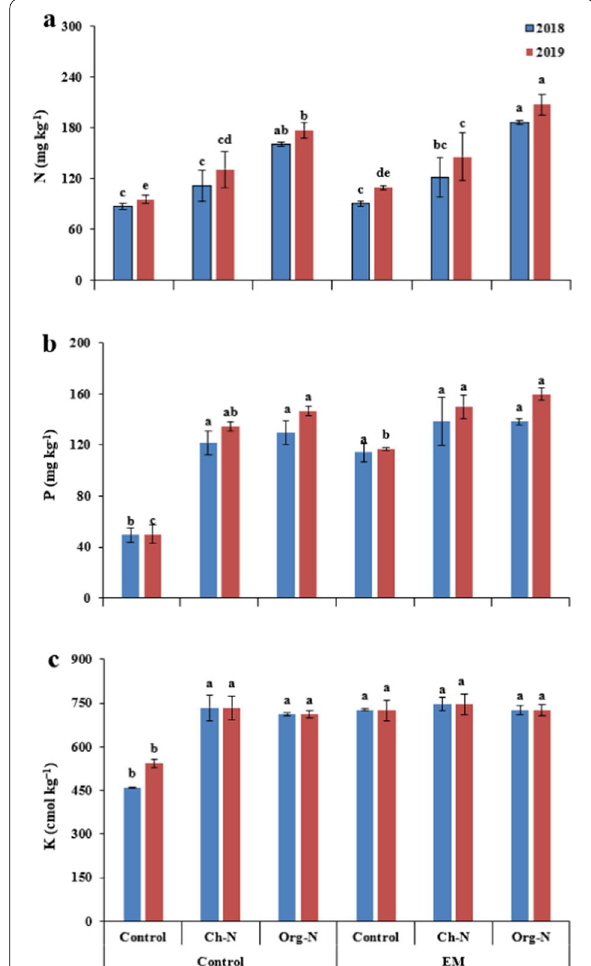
Fig. 5 Effect of nitrogenous fertilizers and effective microorganisms Fig. 6 Effect of nitrogenous fertilizers and effective microorganisms on electric conductivity ( a ), pH ( b ), and soil organic carbon ( c ) of on available nitrogen ( a ), phosphorus ( b ), and potassium ( c ) of soil soil after harvest during two growing seasons (2018–19). Ch-N after harvest during two growing seasons (2018–19). Ch-N chemical chemical nitrogenous fertilizer, Org-N organic nitrogenous fertilizer, nitrogenous fertilizer, Org-N organic nitrogenous fertilizer, EM EM effective microorganisms. Each value expressed in figure is mean effective microorganisms. Each value expressed in figure is mean of two cuttings. Vertical bars indicate mean standard deviation. of two cuttings. Vertical bars indicate mean standard deviation. ± Means followed by the same letter within the same series are not ± Means followed by the same letter within the same series are not significantly different according to Fisher’s least significant difference significantly different according to Fisher’s least significant difference (LSD) technique (p 0.05) (LSD) technique (p ≤ ≤